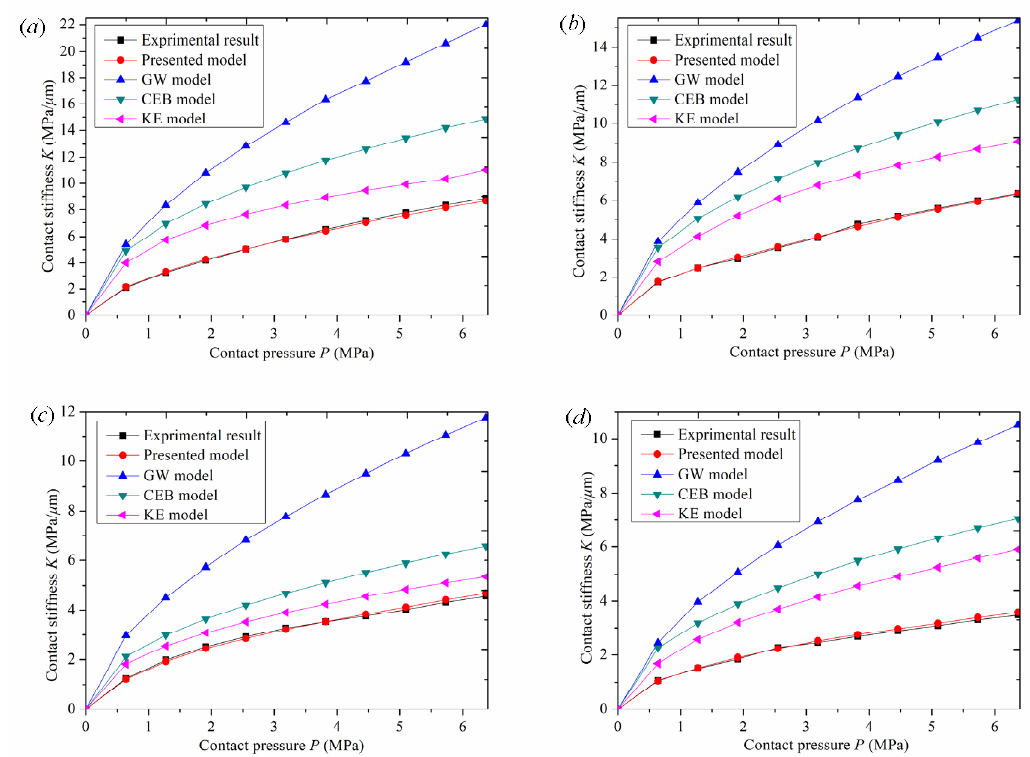
Figure 10. Comparison results of contact stiffness: ( a ) Sa 1.6 μm; ( b ) Sa 3.2 μm; ( c ) Sa 4.5 μm; ( d ) Sa 5.8 μm.